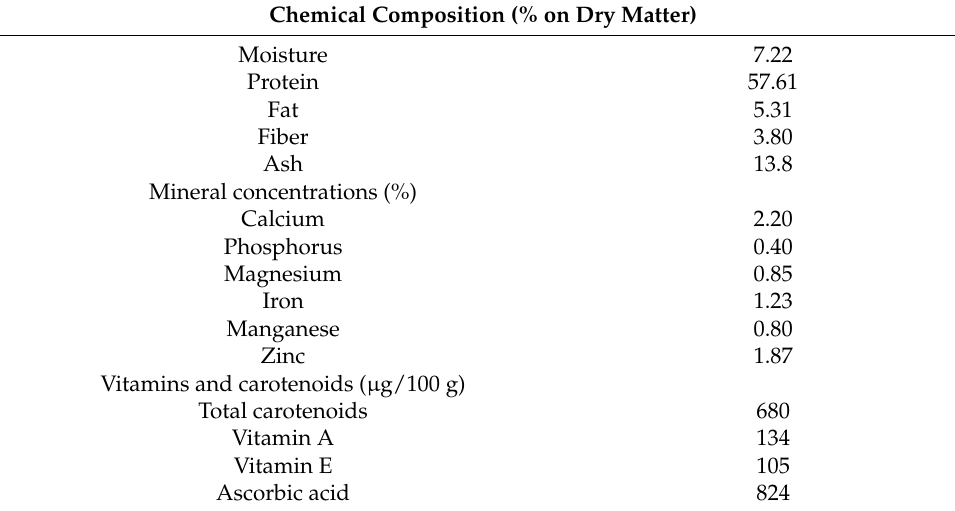
Table 3. Spirulina nutrient